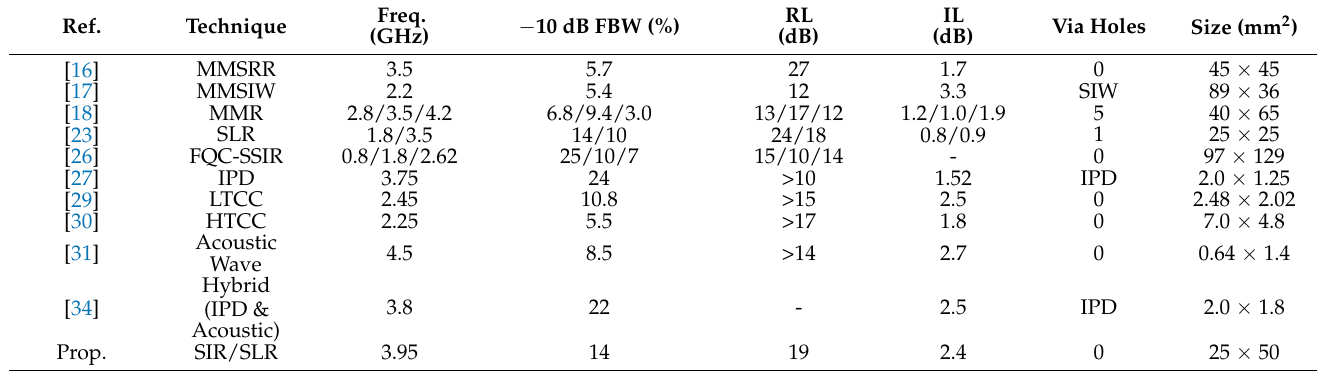
Table 2. Comparison between the proposed design and